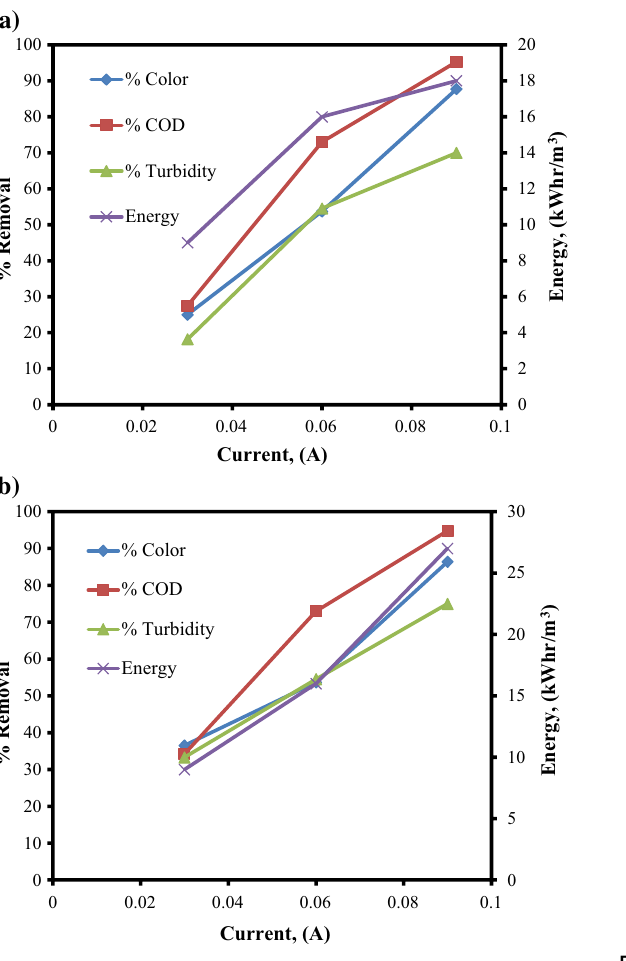
Fig. 5 Removal efficiency and power consumption versus